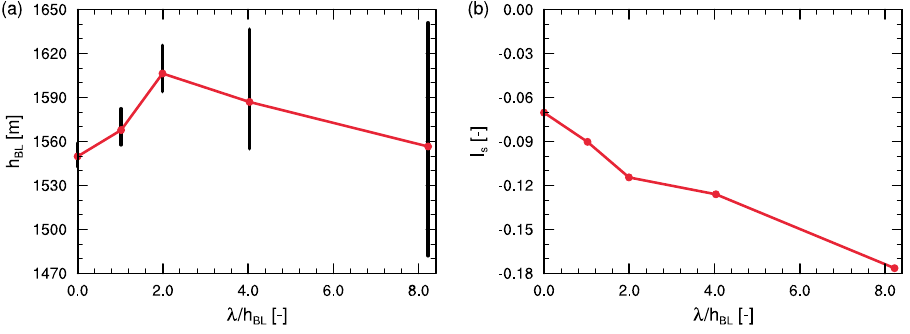
Fig. 10. Dependency of the boundary layer height (a) and the intensity of segregation in the boundary layer for the isoprene-OH Reaction (R9) (b) on the length scale of heterogeneity (i.e. twice the patch size). The homogeneous surface forcing corresponds to a heterogeneous surface forcing with a length scale of 0m. The plotted variables are averages over the fourth hour of simulated time. The boundary layer heights are additionally averaged in the x-direction. The length scales on the bottom axes are normalized by the corresponding averaged boundary layer heights, h BL . In (a) the black vertical lines represent the variability in the hourly averaged boundary layer height in the